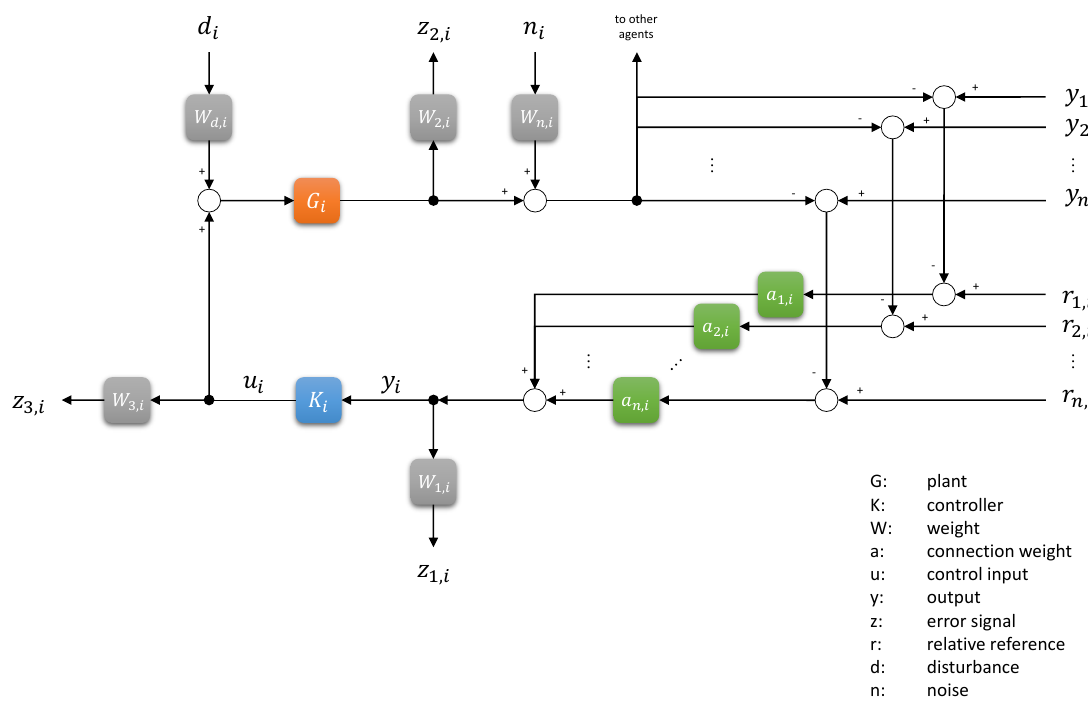
Figure 9. Mixed sensitivity closed-loop system with distributed controller